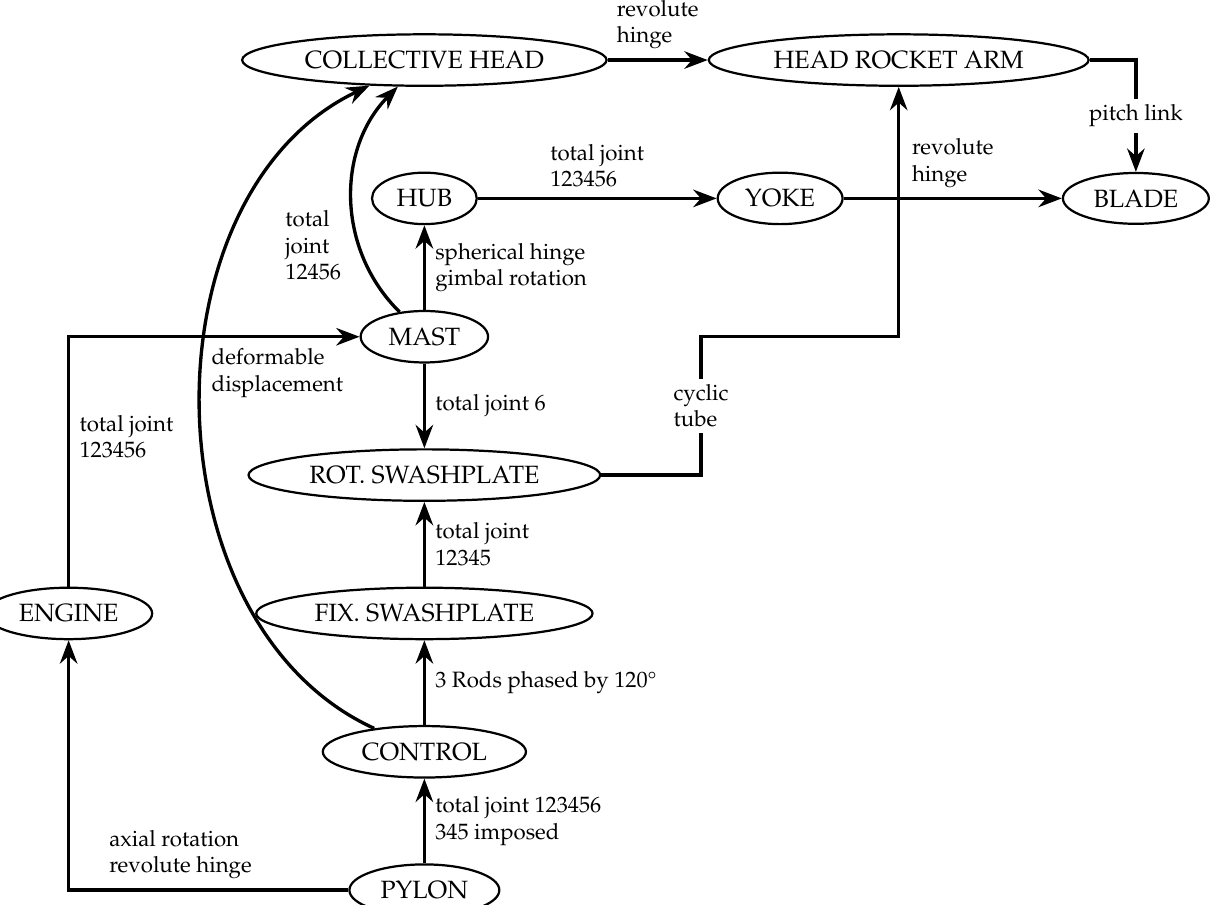
Figure 11. Flowchart of the MBDyn model of the XV-15 proprotor, particularly showing the individual blade pitch control system components and their connections for the dual control path.